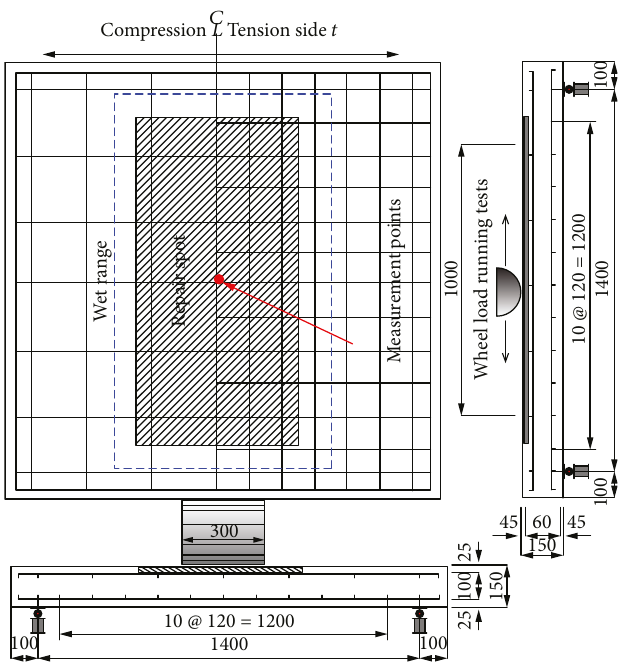
Figure 3: Dimensions of test specimen and plumbing diagram.